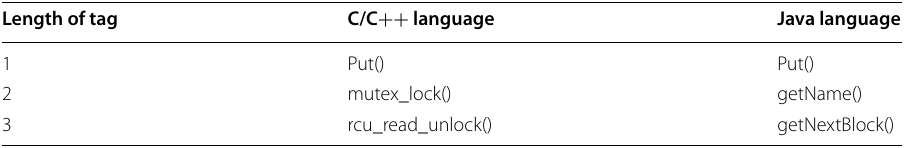
Table 1 Examples of tag lengths for variables and methods Length of